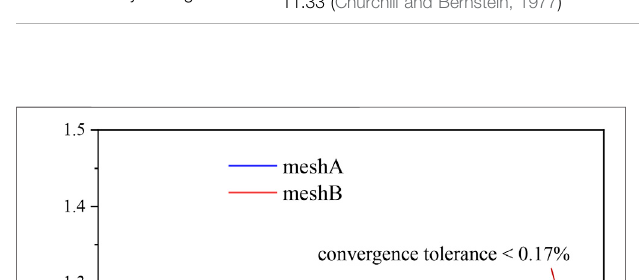
the lift force of cylinder. Supplementary Figure S5 shows the